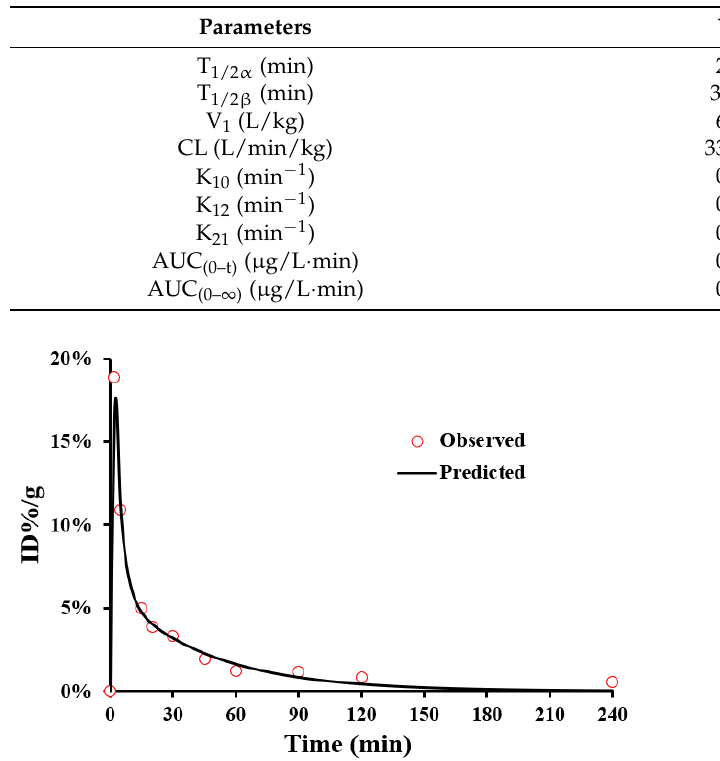
Table 1. Pharmacokinetic parameters of 99m Tc-HYNIC-ADH-1 in C57/BL6 mice (AUC, area under the curve; CL, clearance).